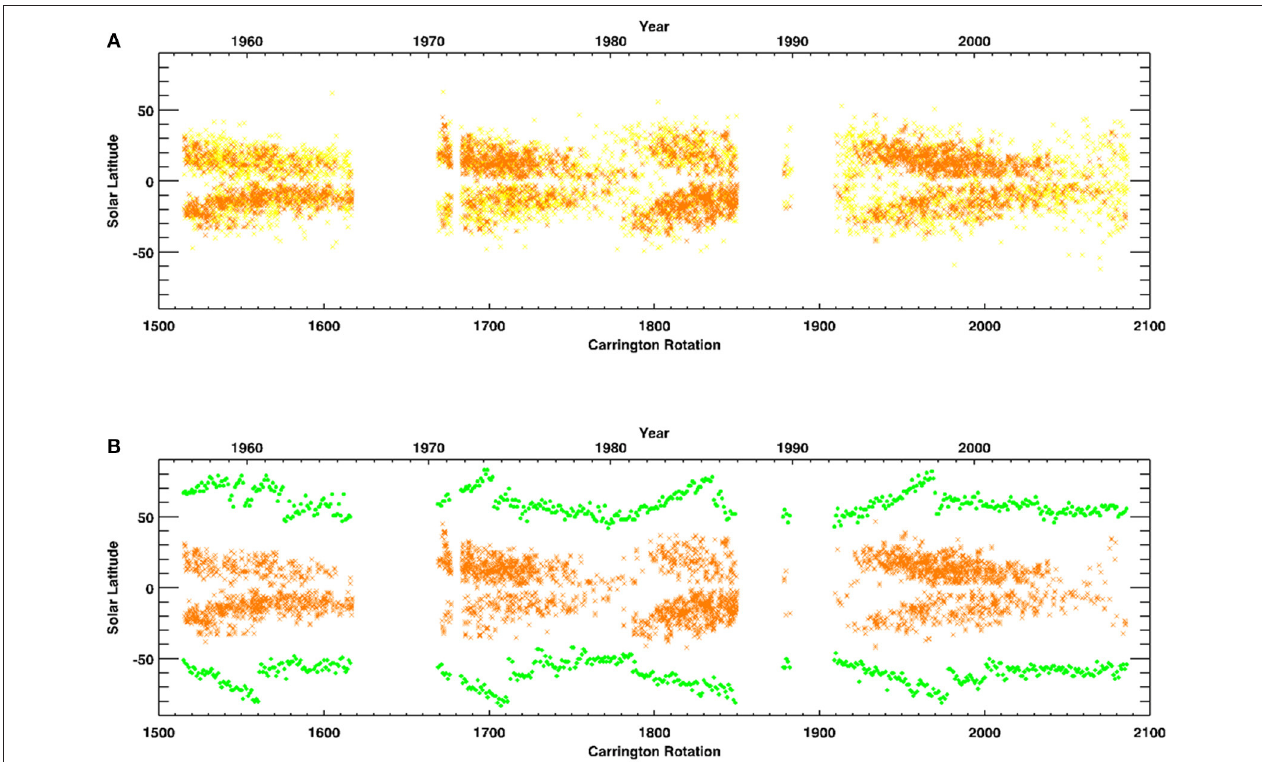
FIGURE 4 | Butterfly-type plots of all of the McA data processed to date starting with CR 1513 in October 1966 and ending with CR 2086 in July 2009. The Year scale is at the top and the CR scale at the bottom. (A) McA plot of sunspots (orange) and plage (yellow), both associated with ARs and revealing the classic butterfly pattern. On each map the sunspot color denotes the sizes and locations of sunspots visible on H-alpha images, whereas the plage color roughly corresponds to the area of bright plage on H α images. (B) Plot of the McA sunspots (orange) and the poleward-most filament boundaries per CR (green) for this period. The same “rush to the poles” as shown in Figure 2 during the rise phases of both SC 22 and 23 is evident as well as the appearance of the new PCF after each maximum.